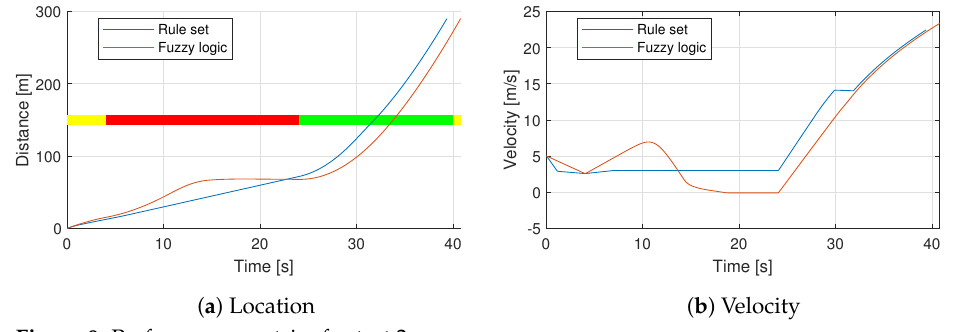
Figure 9. Performance metrics for test